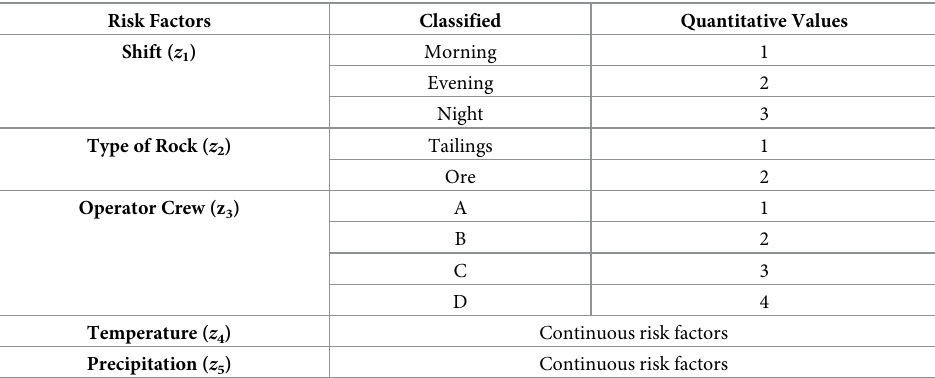
Table 1. The classification of risk factors.